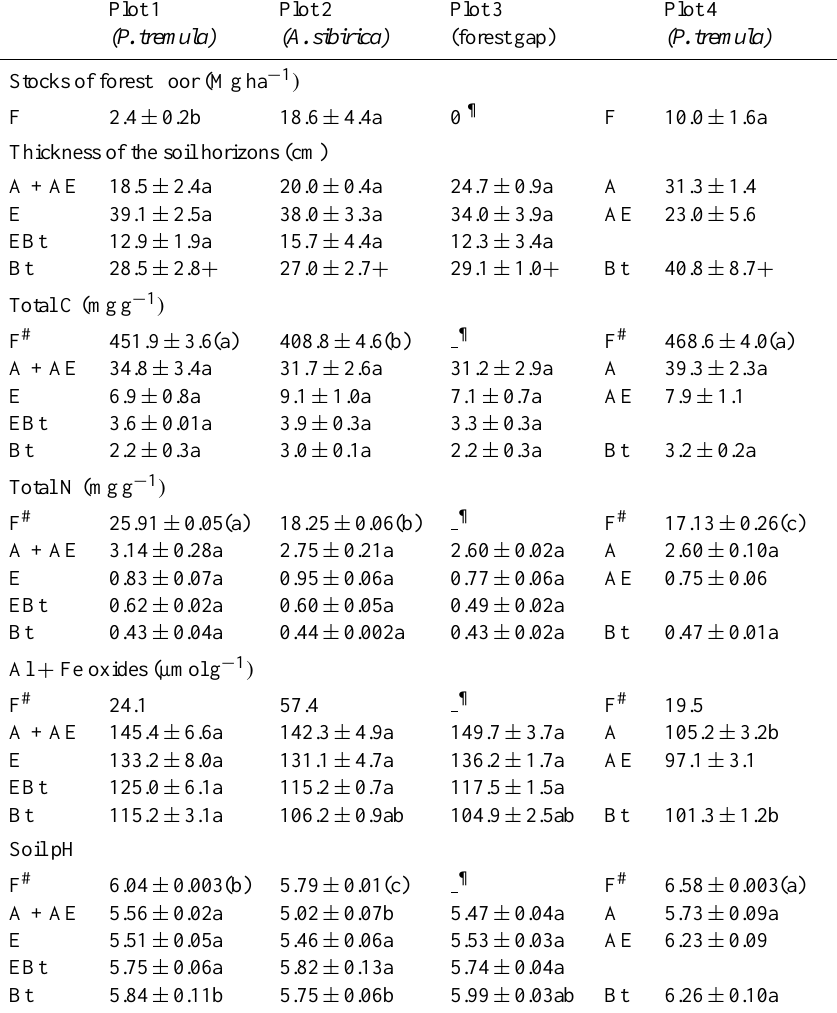
Table 1. Stocks of forest floor, description of the soil profiles and main physicochemical soil properties. Plot 1 Plot 2 Plot 3 Plot 4 (P. tremula) (A. sibirica) (forest gap) (P.